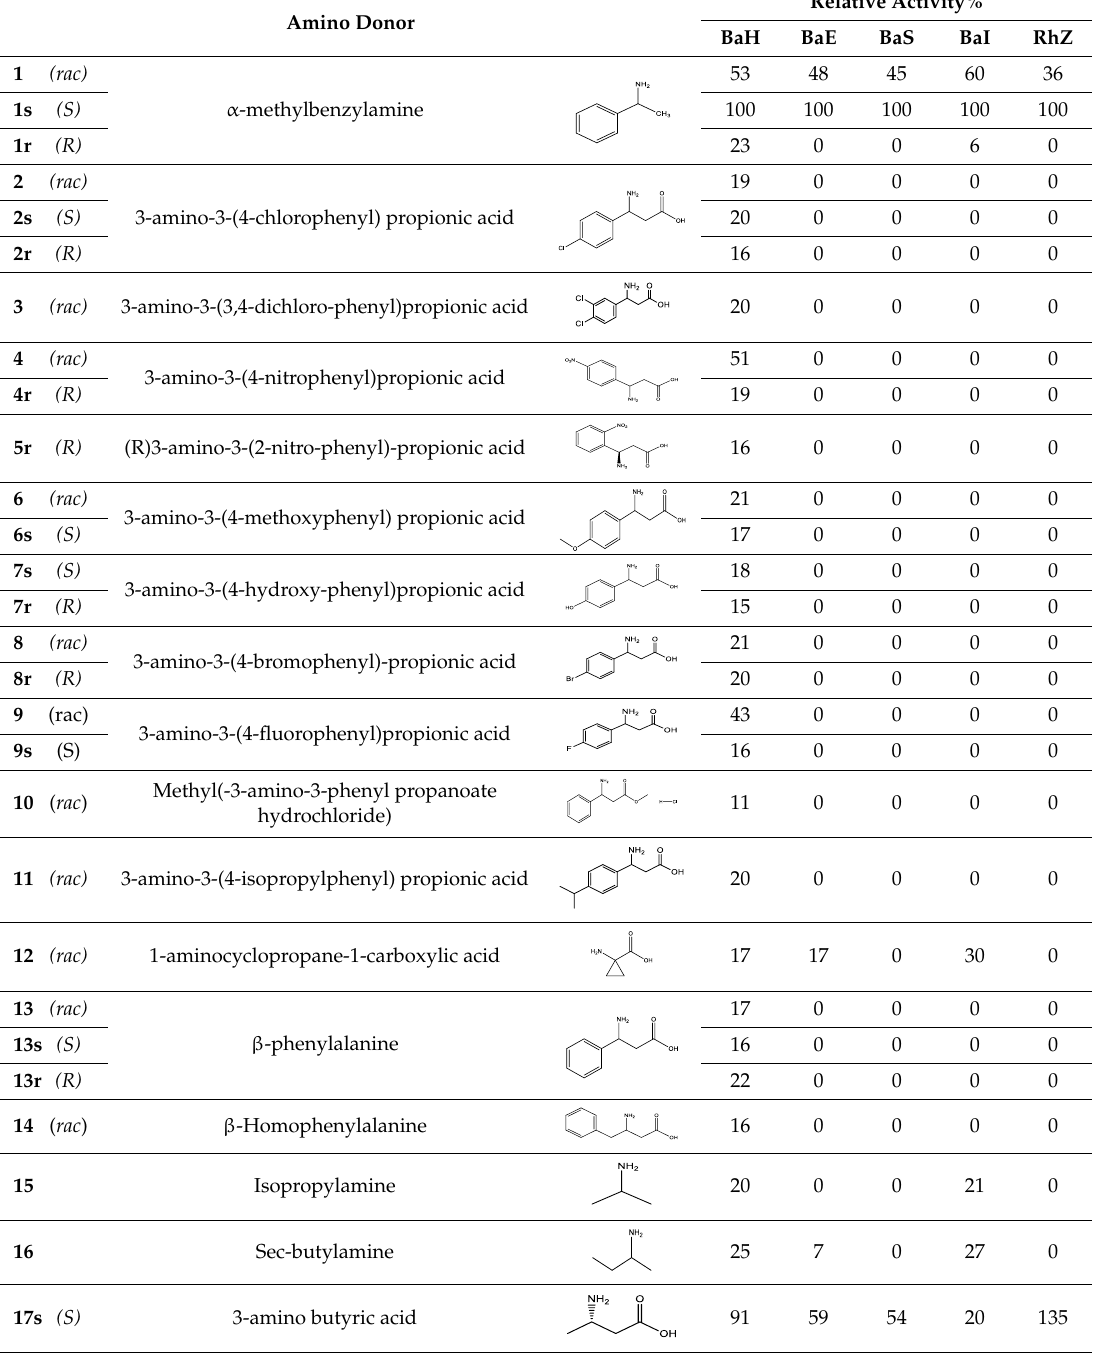
Table 2. Amino donor screened assays were carried out in Britton–Robinson buffer, pH 7 with amino donor (10 mM), pyruvate (10 mM), PLP (0.1 mM), and 15% ( v/v ) DMSO. The reaction was initiated by